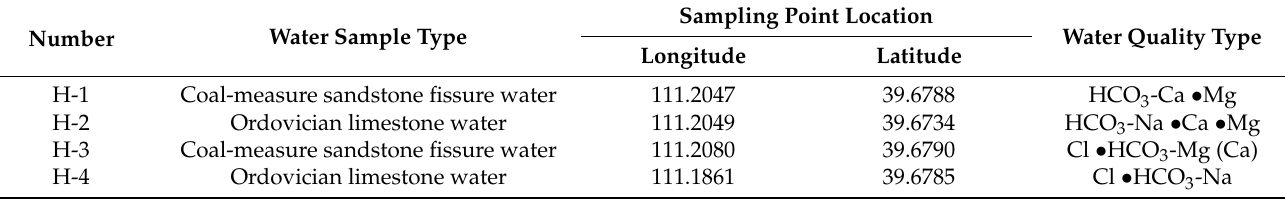
Table 1. Water sample point